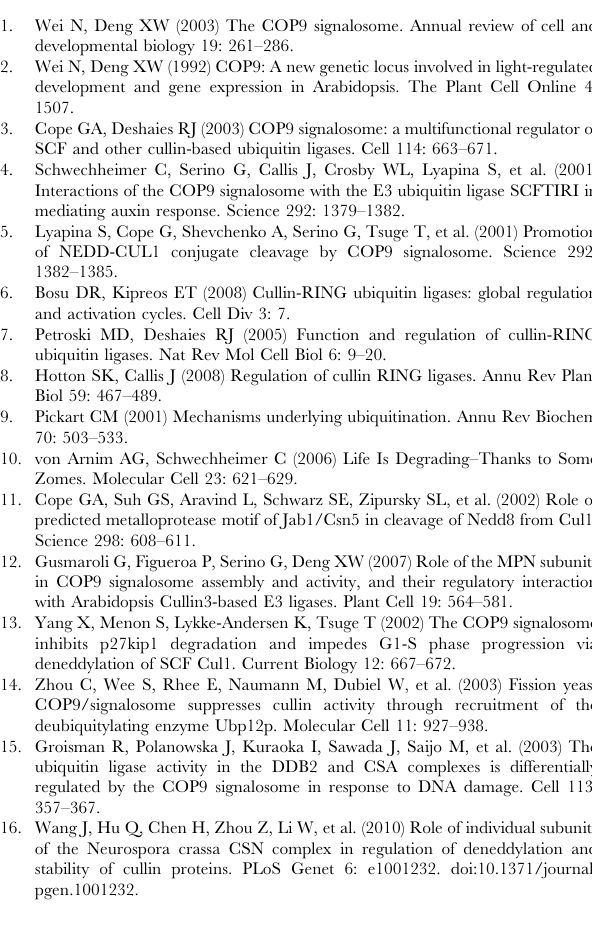
Figure S1 Expression of Myc-Cul1 in the first generation of csn- 1 KO , csn-5 KO , and csn-6 KO transformants. The positive transfor- mants showing the expression profile of Myc-Cul1 in the csn-1 KO , csn-5 KO , and csn-6 KO strains. Western blot analysis was performed using c-Myc antibody. Note that the total protein loaded into each lane was not quantified for identifying positive